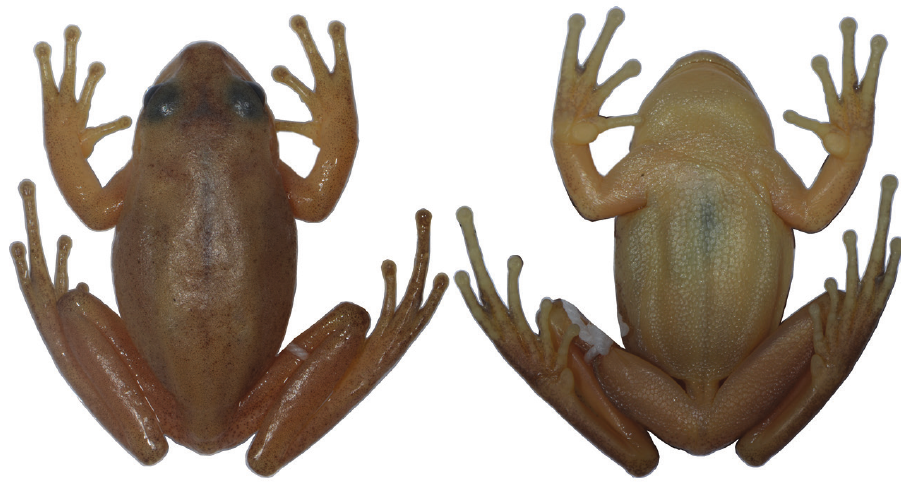
Figure 2. Dorsal and ventral views of the Holotype of Aplastodiscus lutzorum sp. n. (AAG-UFU